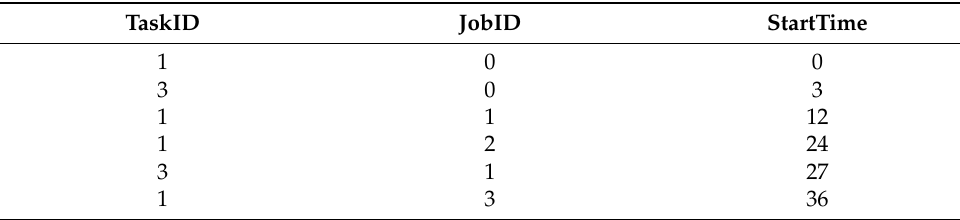
Table 3. Hi-criticality mode scheduling table for the task set in Table 1.